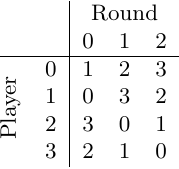
Table 1: A round-robin tournament of order 4 where the entry in row i and column j gives the player that opposes i in round j